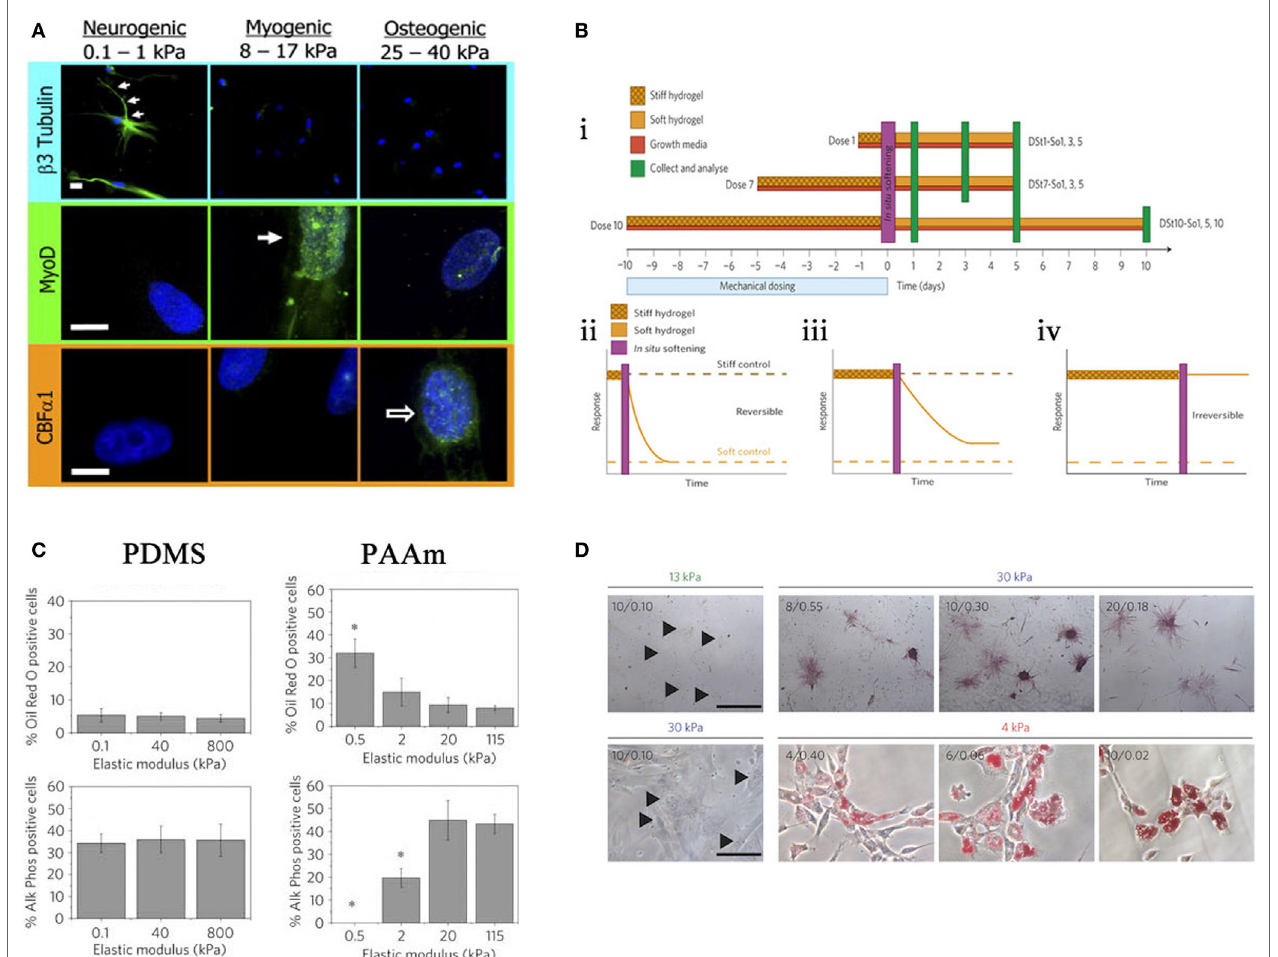
FiGURe 4 | effects of stiffness . (A) Altering stiffness results in differentiation into specified lineages, soft, intermediate, and hard matrices induce the differentiation of neuronal, myogenic, and osteogenic phenotypes, respectively. Reprinted (adapted) from Cell, copyright (2006) (Engler et al., 2006). (B) The effects of preculturing hMSCs on stiff substrates prior to seeding. ii. 1 day, iii. 7 days, iv. 10 days, where long-term pre-treatment resulted in maintenance of phenotype. Reprinted (adapted) from Nature , copyright (2013) (Gilbert et al., 2010). (C) Altering the elastic modulus resulted in same trend as (A) for PAAm substrates but not PDMS. Reprinted (adapted) from Nature ref copyright (2012) (Trappmann et al., 2012). (D) Altering the pore size of substrates does not result in changes in differentiation for that stiffness. Reprinted (adapted) from Nature, copyright (2014) (Wen et al.,